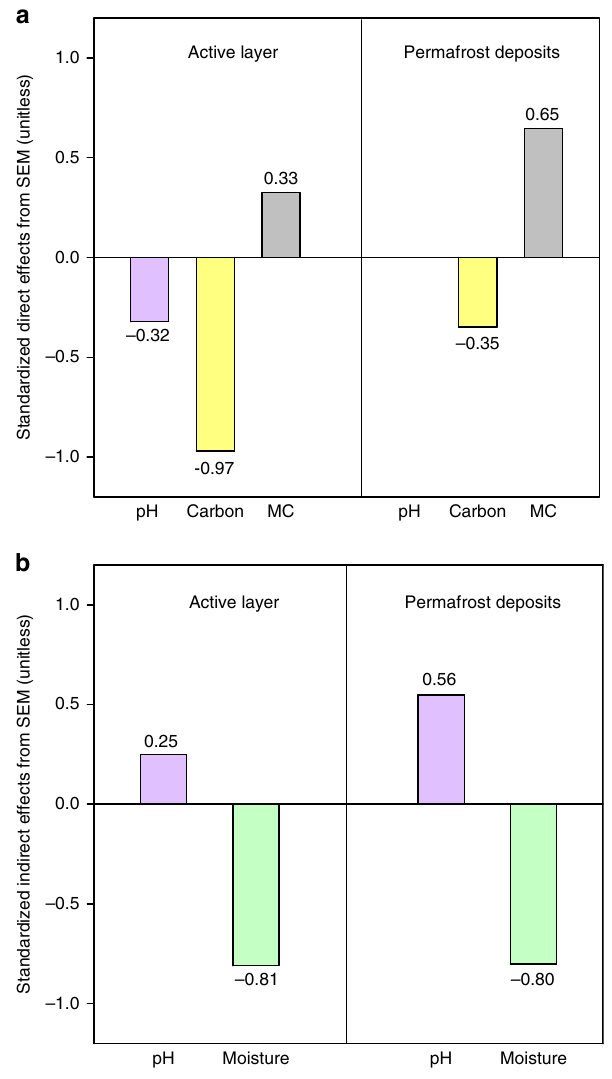
Figure 5 | Standardized effects derived from the structural equation modeling (SEM). ( a ) Direct effects and ( b ) indirect effects of soil moisture (green bars), pH (purple bars), C recalcitrance (Carbon; yellow bars, first components from a PCA conducted with cutin-derived components, suberin-derived components, lignin cinnamyl units, C:N, fast C pool size and slow C pool size) and soil microbial community (MC; grey bars, first component from a PCA conducted with total PLFAs, fungal PLFAs, actinomycete PLFAs, and the fungi/bacteria ratio) on soil CO 2 –C release from SEM. The soil moisture data used in the SEM were the moisture in the field rather than that during incubation. The numbers adjacent to bar are the standardized coefficients in